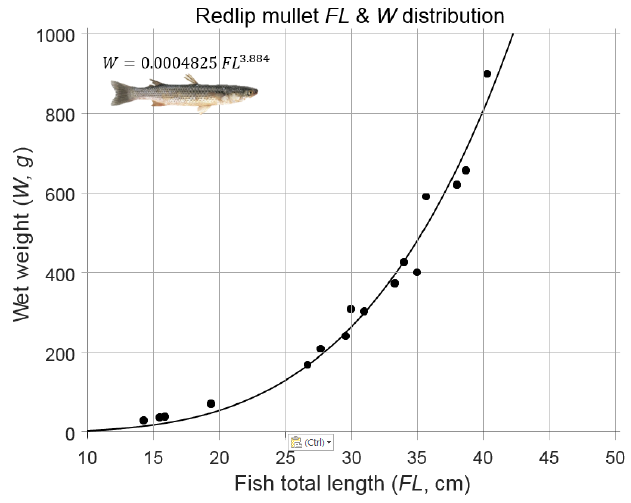
Figure 1. The relationship between total fish length ( FL , cm) and wet weight ( W , g) of 16 live Redlip mullets ( Chelon haematocheilus ).